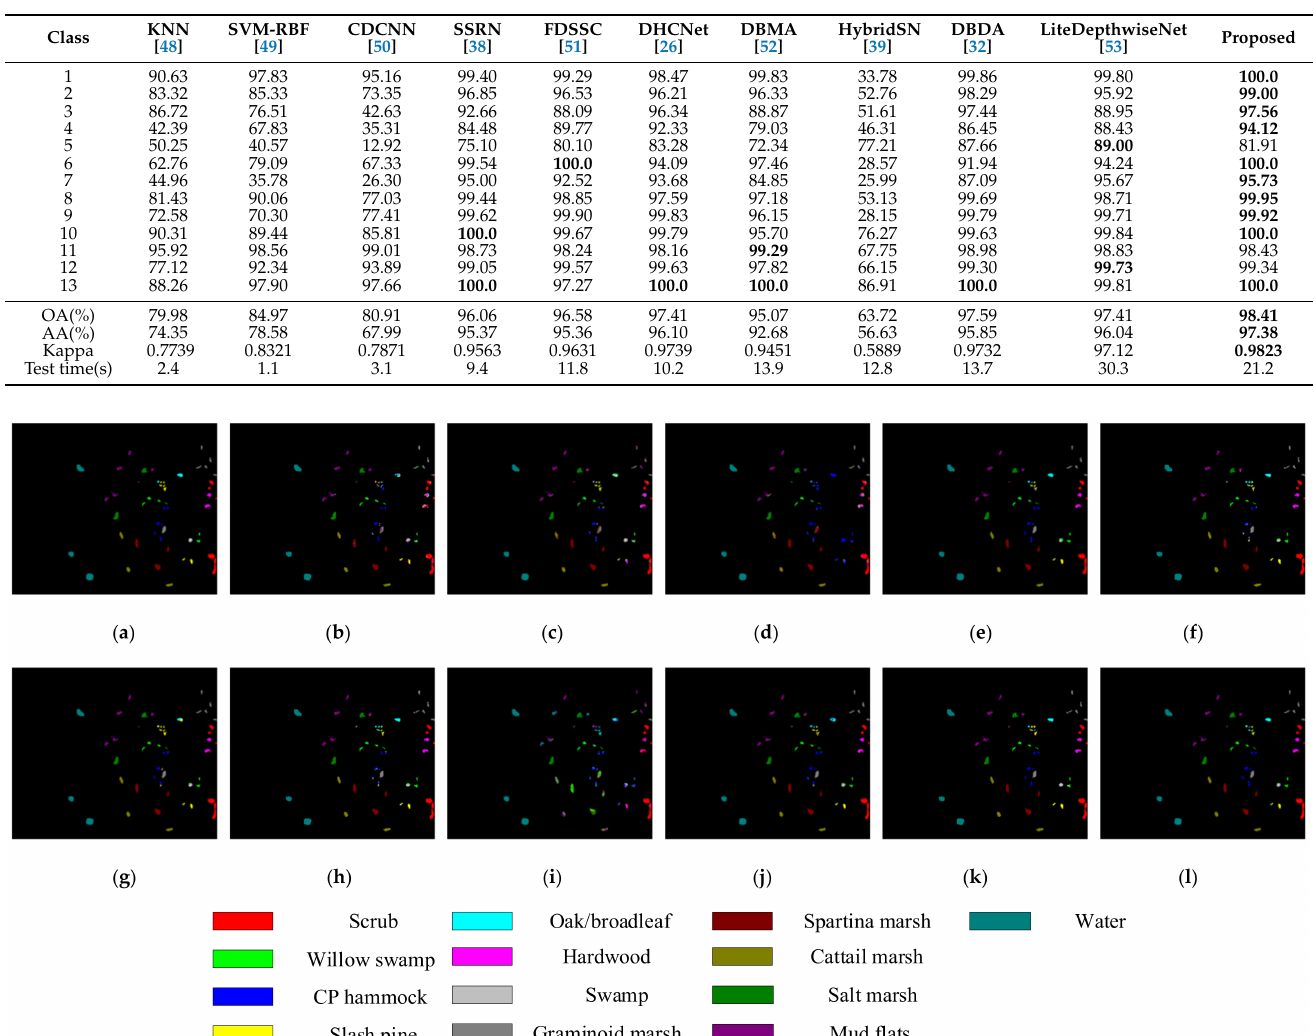
Table 8. KPI (OA, AA, Kappa) on the Kennedy Space Center (KSC) dataset with 5% training samples.